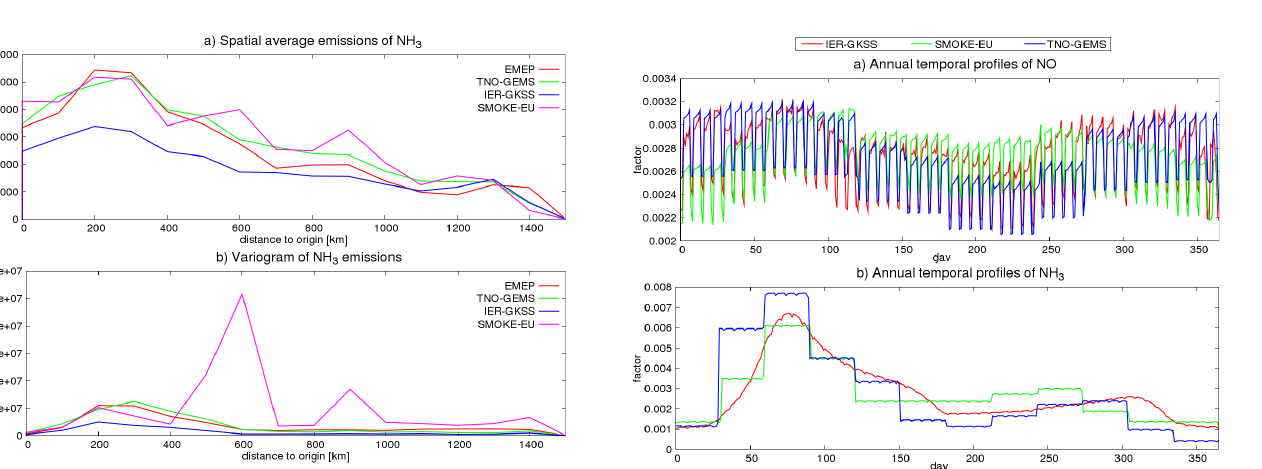
Fig. 10. Averaged annual temporal profiles with daily resolution of different emission datasets for the year 2000 on a 54 × 54km 2 domain (Fig. 2). (a) NO emissions (b) NH 3 emissions. The biogenic NO emissions included in the SMOKE-EU dataset lead to higher average emissions in summer and lower average emissions in winter.